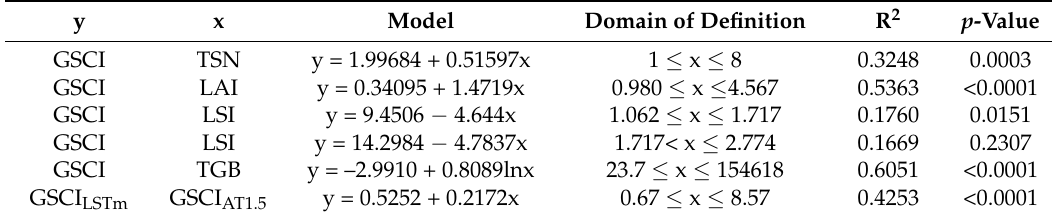
Table 7. Linear regression models for GSCI versus LAI, LSI, TGB, and AT 1.5 .